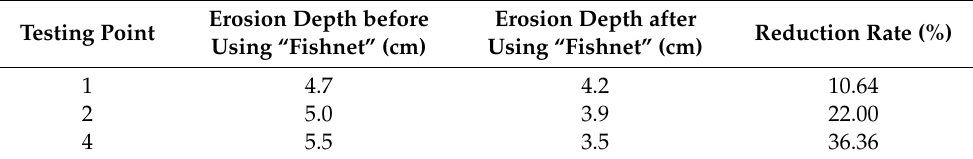
Table 4. E ff ectiveness investigation results of the “fishnet” technology.